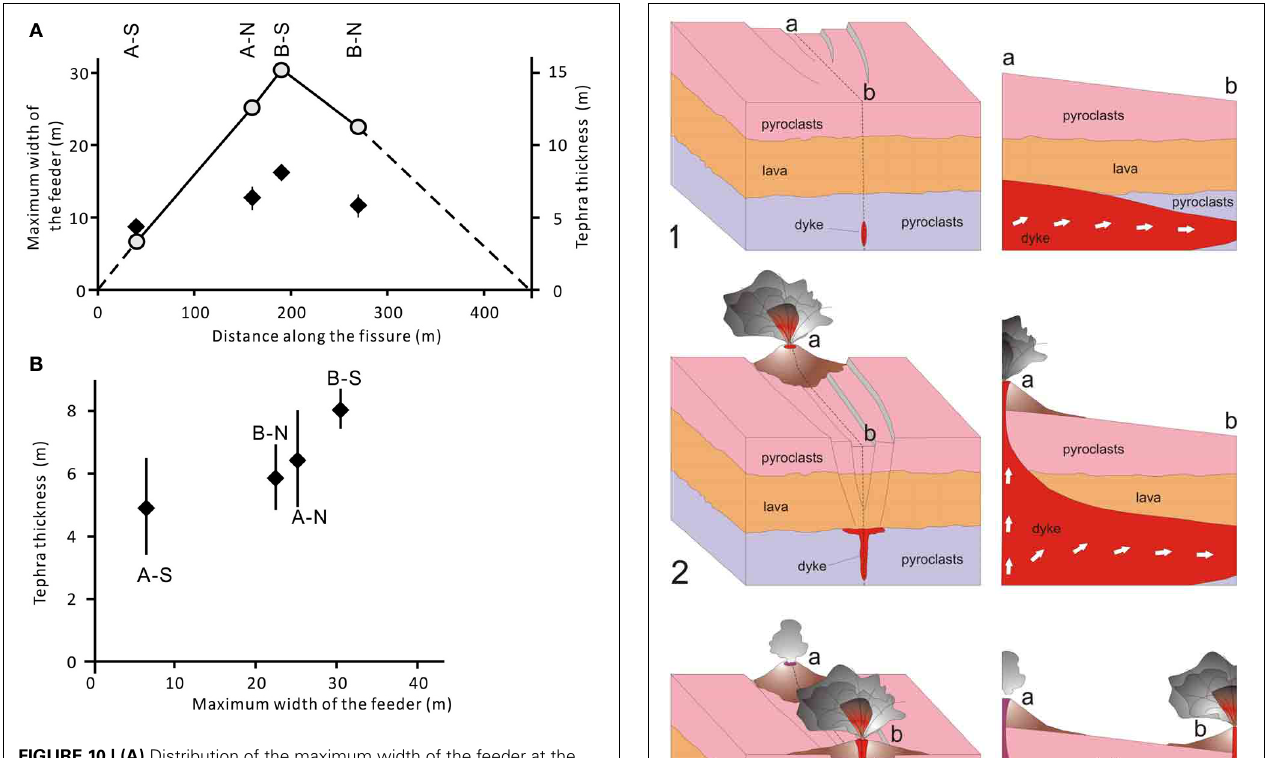
FIGURE 10 | (A) Distribution of the maximum width of the feeder at the original ground surface (scale on left) and the thickness of the scoriaceous tephra at the crater (A and B) margin (scale on right). Distance is measured along the eruptive fissure 3 from its southern edge. (B) Thickness of the scoriaceous tephra at the crater (A and B) margin plotted against the width of the feeder at the original ground surface.